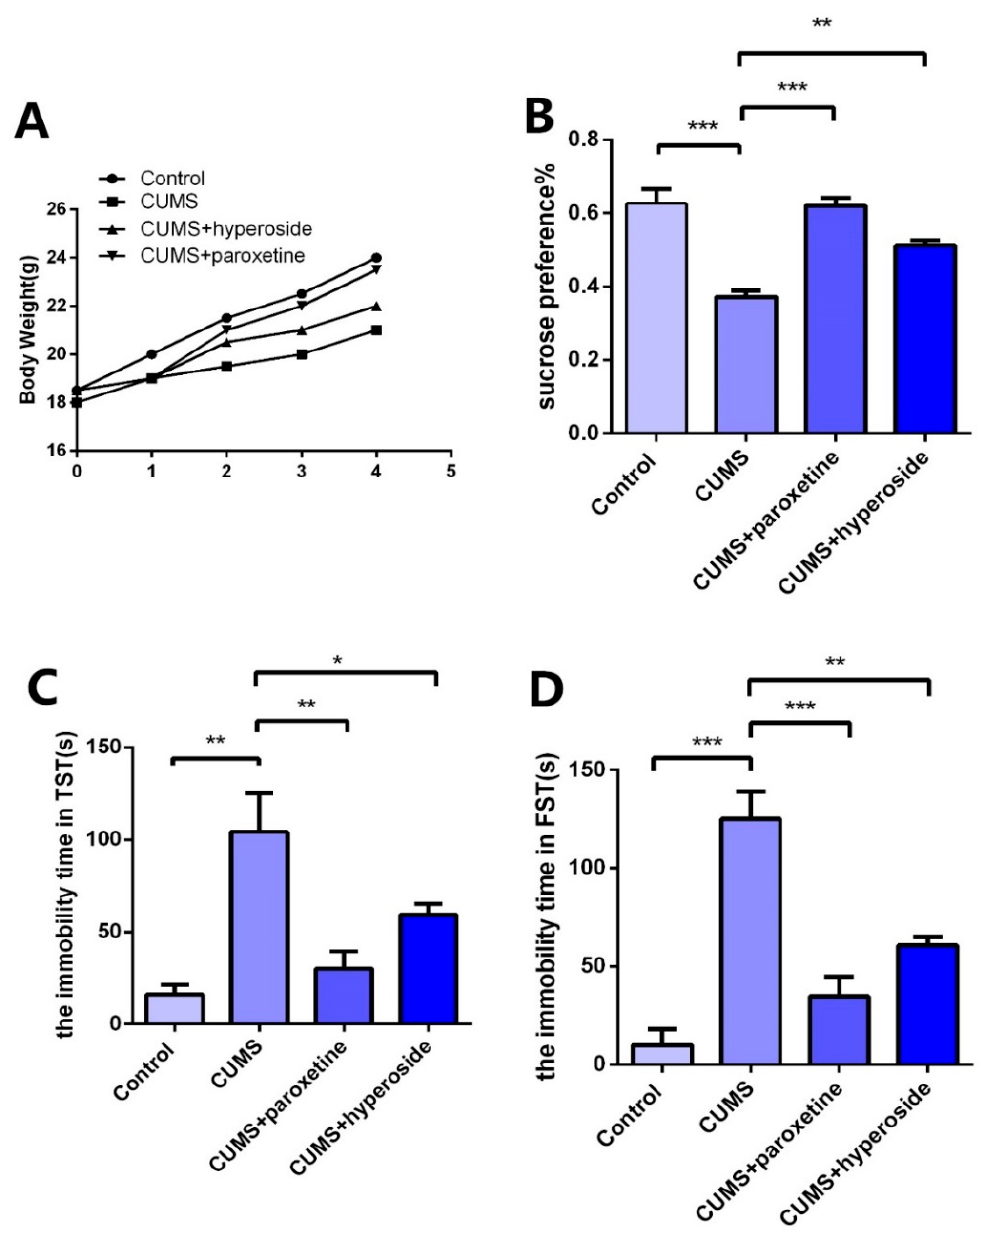
Figure 6. Effects of Hyp on depressive-like behaviors of chronic stress-induced mice. ( A ) Compared with the control group, the CUMS group had a slower rate of body weight growth. Body weight growth was faster in the CUMS+paroxetine and CUMS+Hyp groups than in the CUMS group. ( B ) Hyp and paroxetine significantly increased the sucrose preference rate of CUMS mice in the sucrose preference test. ( C ) Compared with the control group, the CUMS group increased the immobility time of TST. TST immobility time was significantly reduced by CUMS+paroxetine and CUMS+Hyp. ( D ) The immobility time of the FST was increased in the CUMS group compared with the control group. CUMS+paroxetine and CUMS+Hyp significantly decreased the immobility time of FST. Results are shown as the mean from multiple experiments, n = 5, one-way ANOVA, followed by Dunnett multiple comparison test; * p < 0.05, ** p < 0.01, and *** p < 0.001.